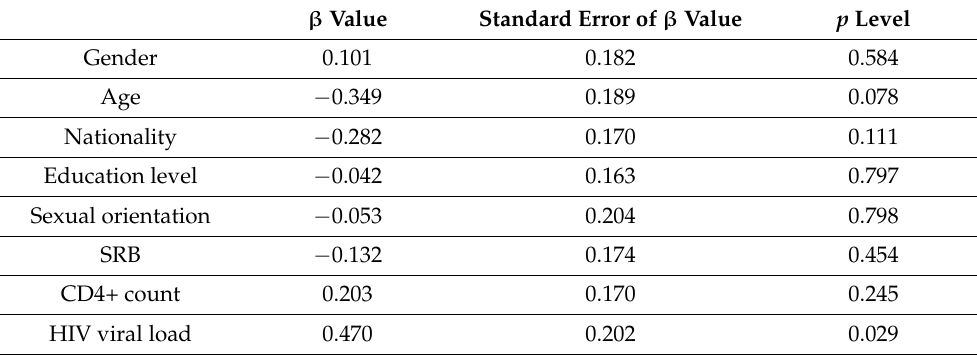
Table 2. Multivariate regression analyses of the studied variables and the oral HPV presence in the HIV+ group (R2 =